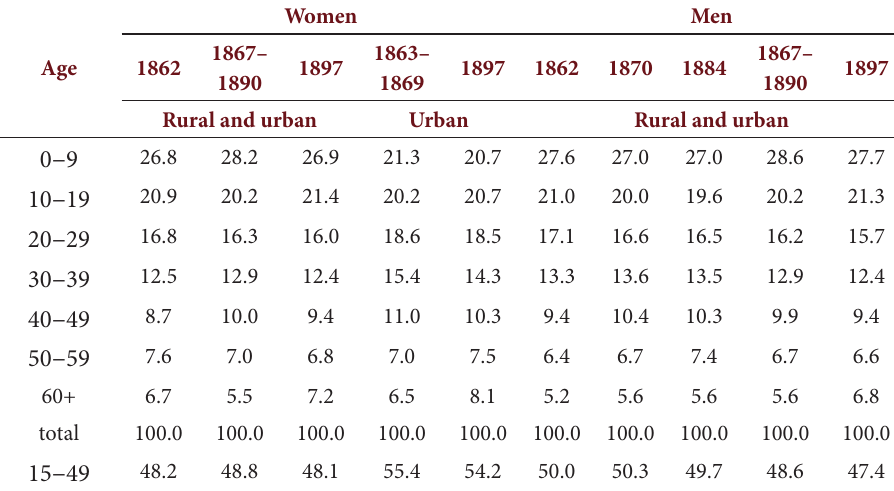
Table 1. Age composition of the Orthodox population of 50 provinces in European Russia